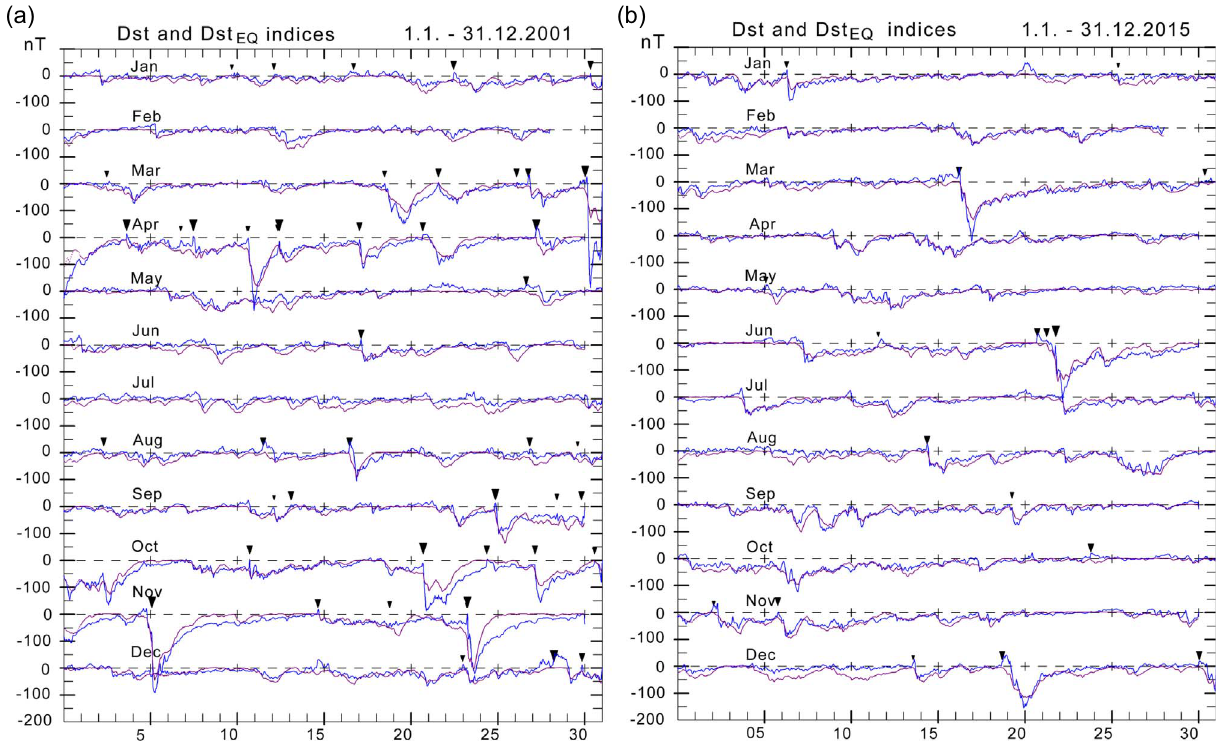
Fig. 15. Observed Dst values (blue line) and calculated Dst EQ values (magenta) for (a) 2001 and (b) 2015. Storm Sudden Commencement (SSC) events are displayed by the downward pointing black triangles to indicate times and sized to indicate their amplitudes.